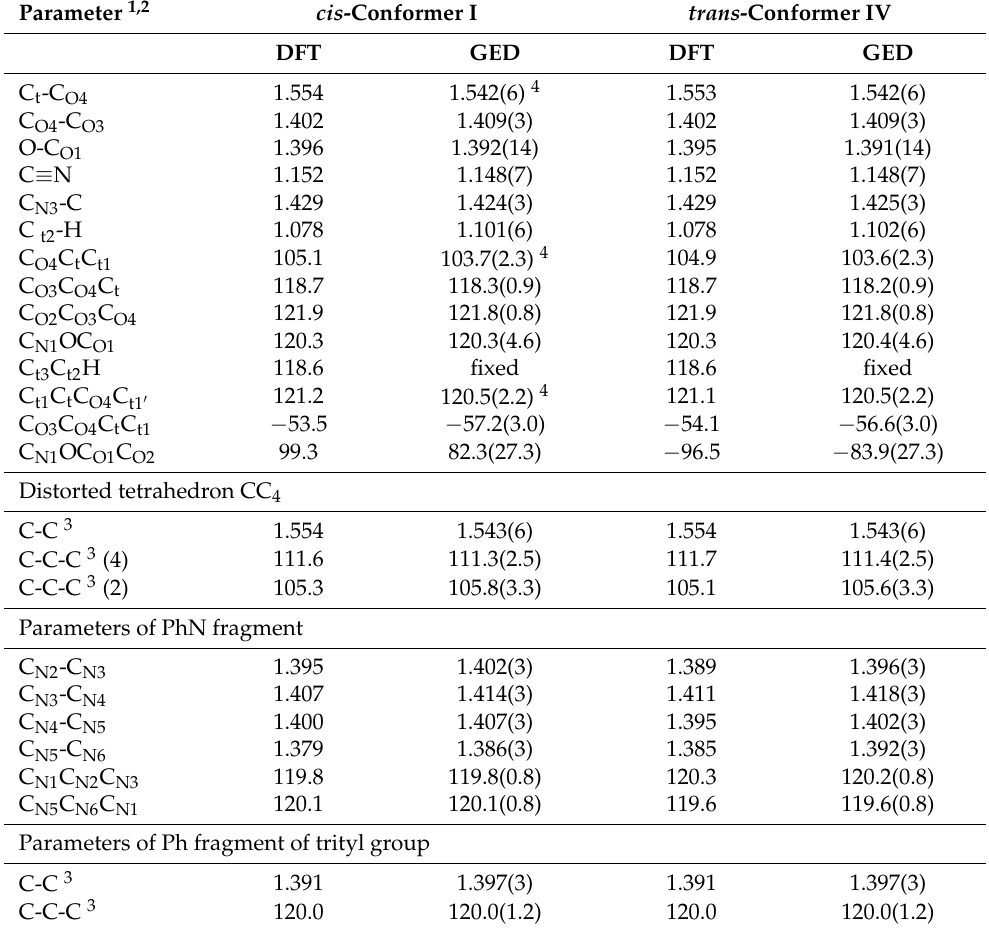
Table 3. Experimental and theoretical parameters of cis- and trans